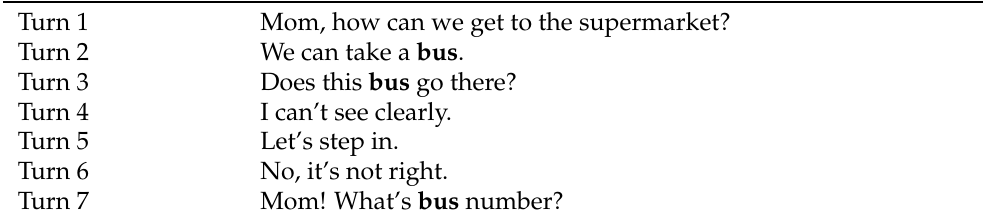
Table 1. A conversation between two people in which the last turn requires information from earlier in the